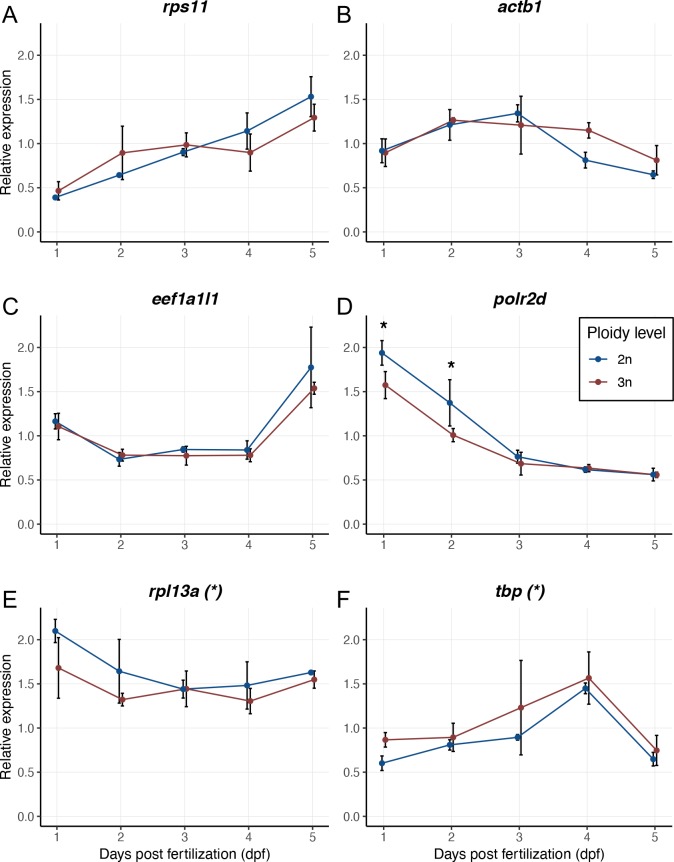
Relative expression values of housekeeping genes in diploid and triploid larvae during development.A) rps11, ribosomal protein S11. B) actb1, actin, beta 1. C) eef1a1l1, eukaryotic translation elongation factor 1 alpha 1, like 1. D) polr2d, polymerase (RNA) II (DNA directed) polypeptide D. E) rpl13a, ribosomal protein L13a. F) tbp, TATA box binding protein. Expression values for each gene are normalized using a combined index of the relative quantity of the other five housekeeping genes. Values are presented as means with standard deviations. Asterisks in titles indicate a significant difference in expression levels without an interaction with dpf. ANOVA, * p < 0.05, n = 3x3 larvae per ploidy level per day.